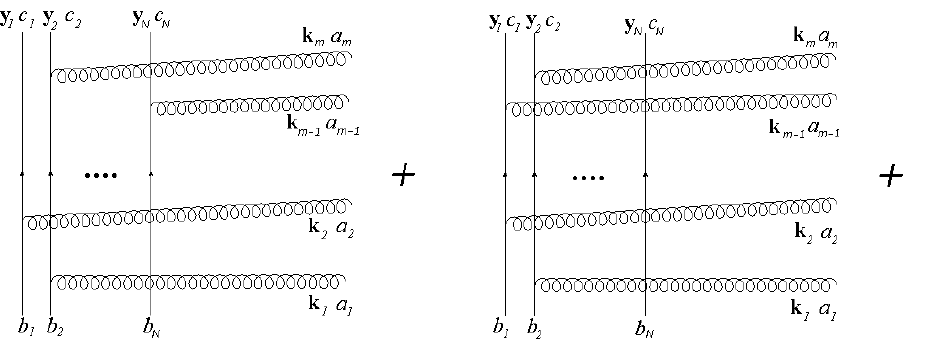
Figure 1 . Two of the N m diagrammatic contribution to the m -gluon emission amplitude from N sources. The N partonic line sources in adjoint representation start with initial colors b j and, after emitting gluons, end at (cid:12)nal color c j . Emitted gluons are regarded as being ordered in rapidity, see text for